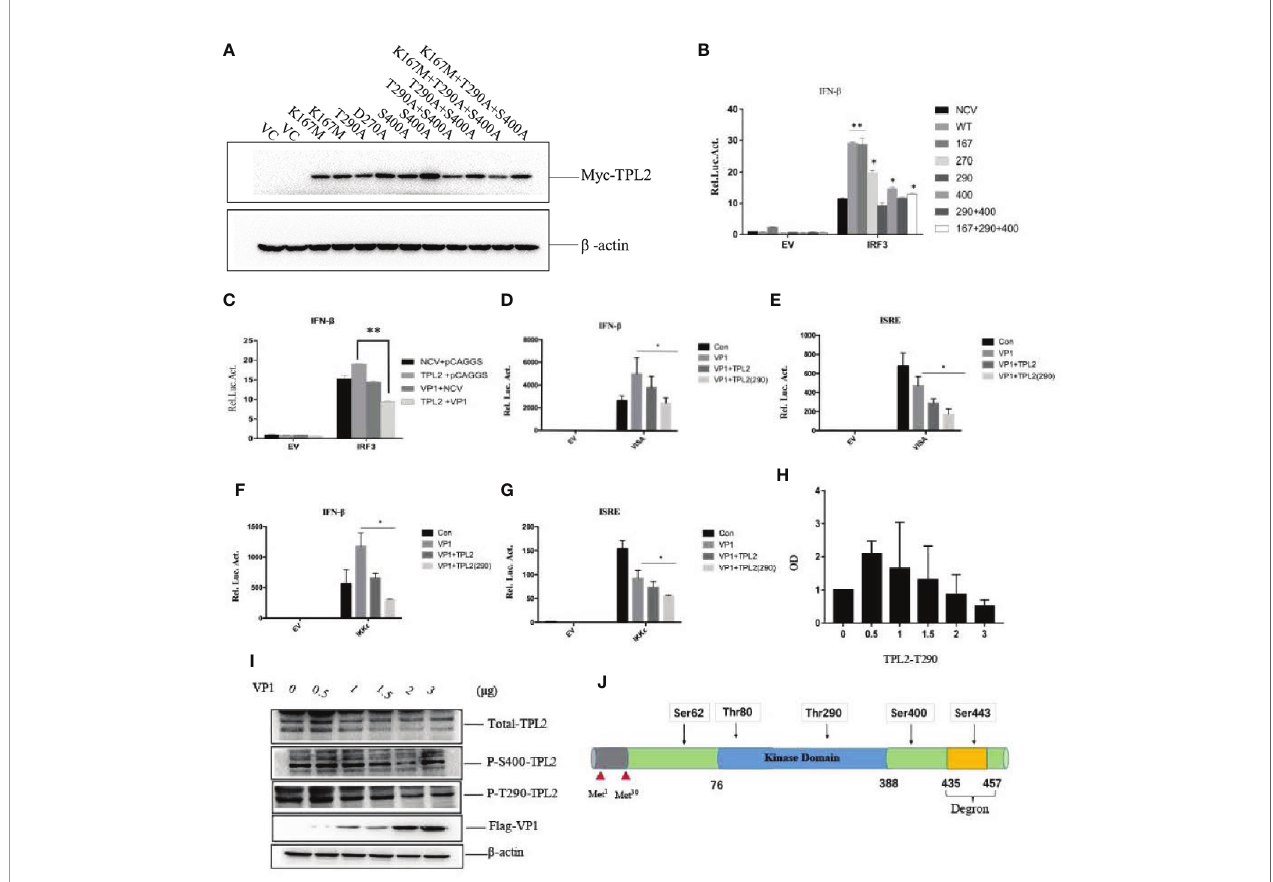
FIGURE 6 | FMDV VP1 inhibits TPL2 phosphorylation at the Thr290 site. (A) HEK293T cells were transfected with TPL2 functional site mutant plasmids. Vector plasmids (pCMV-3N-Myc) were used as vector control (VC). Except for plasmids of T290A and D270A, the others occupied two lanes. (B) HEK293T cells were transfected with 10 ng WT Myc-TPL2, 10 ng mutant Myc-TPL2, 100 ng IFN- b -Luc reporter plasmid, 10 ng PRL-TK internal reference plasmid, the pCMV − 3N-Myc empty vector, and the HA-IRF3 plasmid. Cells were collected at 24 h after transfection for evaluation by dual-luciferase assay. (C) HEK293T cells were transfected separately with Myc-TPL2 (10 ng), Flag-VP1 (100 ng) with 100 ng IFN- b -Luc reporter plasmid, 10 ng PRL-TK internal reference plasmid, pCMV-3N-Myc empty vector, pCAGGS empty vector, and HA-IRF3 plasmid. 24 h later, activity was detected using the dual-luciferase assay. (D – G) HEK293T cells were transfected separately with IKK ϵ , VISA, Myc-TPL2, TPL2(290) at 10 ng, and Flag-VP1 together with 100 ng of an IFN- b -Luc reporter plasmid, 10 ng PRL-TK internal reference plasmid, pCMV-3N-Myc empty vector, pCAGGS empty vector and HA-IRF3 plasmid. (H, I) Cells were transfected with 0, 0.5, 1, 1.5, 2, or 3 m g of VP1 expression plasmid together with the pCAGGS empty vector; cells were then collected at 24 h after transfection to evaluate protein expression and gene transcription. (J) Sketch map of TPL2 structure and phosphorylation